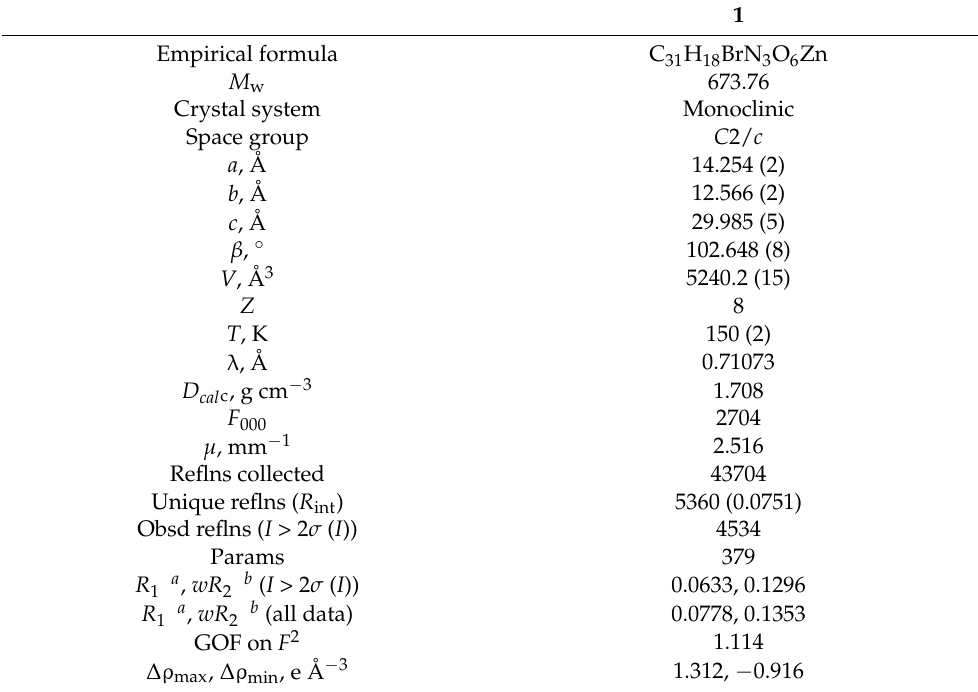
Table 1. Crystallographic data for 1